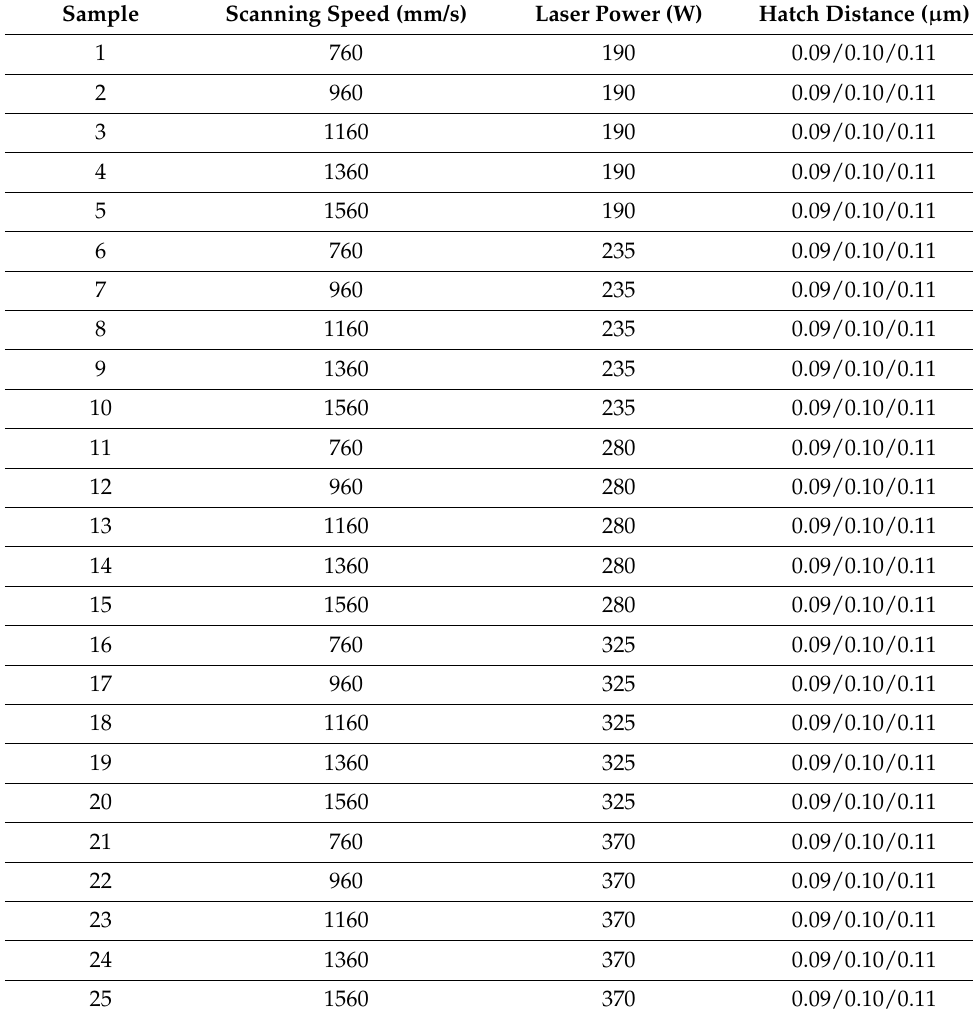
Table 3. Grid values used in IN718 case study (Layer Thickness 30